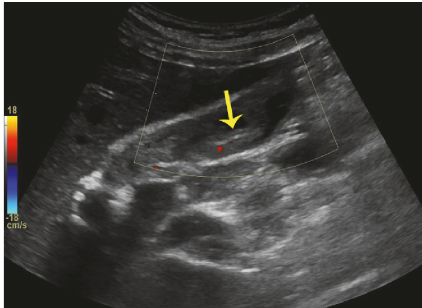
Figure 1: Abdominal ultrasound with filling defect in bile duct.